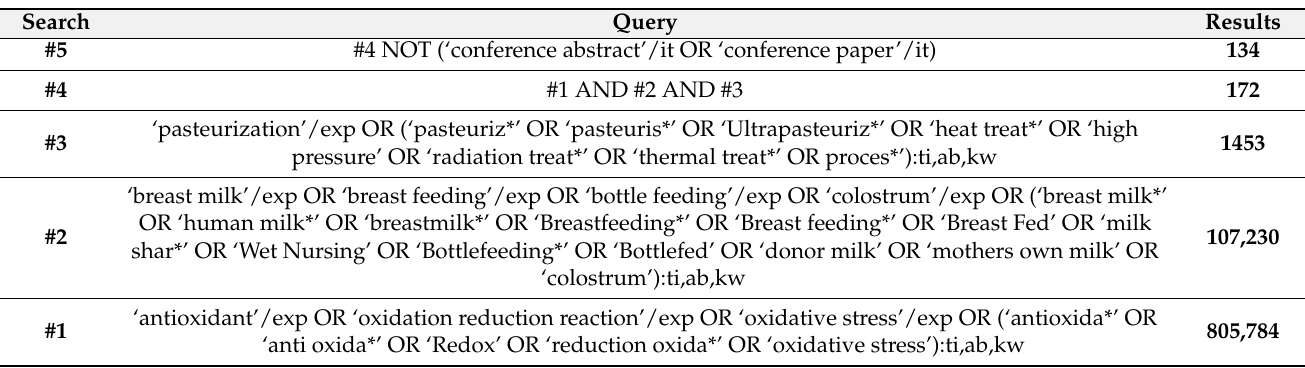
Table A2. Search strategy in Embase.com (accessed on 27 May 2021).